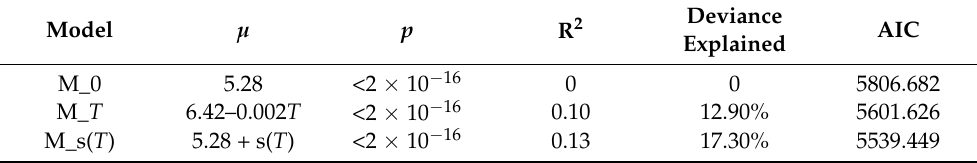
Figure 4. Time series of aerosol extinction coefficient per unit of mass and the fitting results of the stationary and time-varying models. Table 1. Summary of the fitting parameters for the stationary and time-varying models.